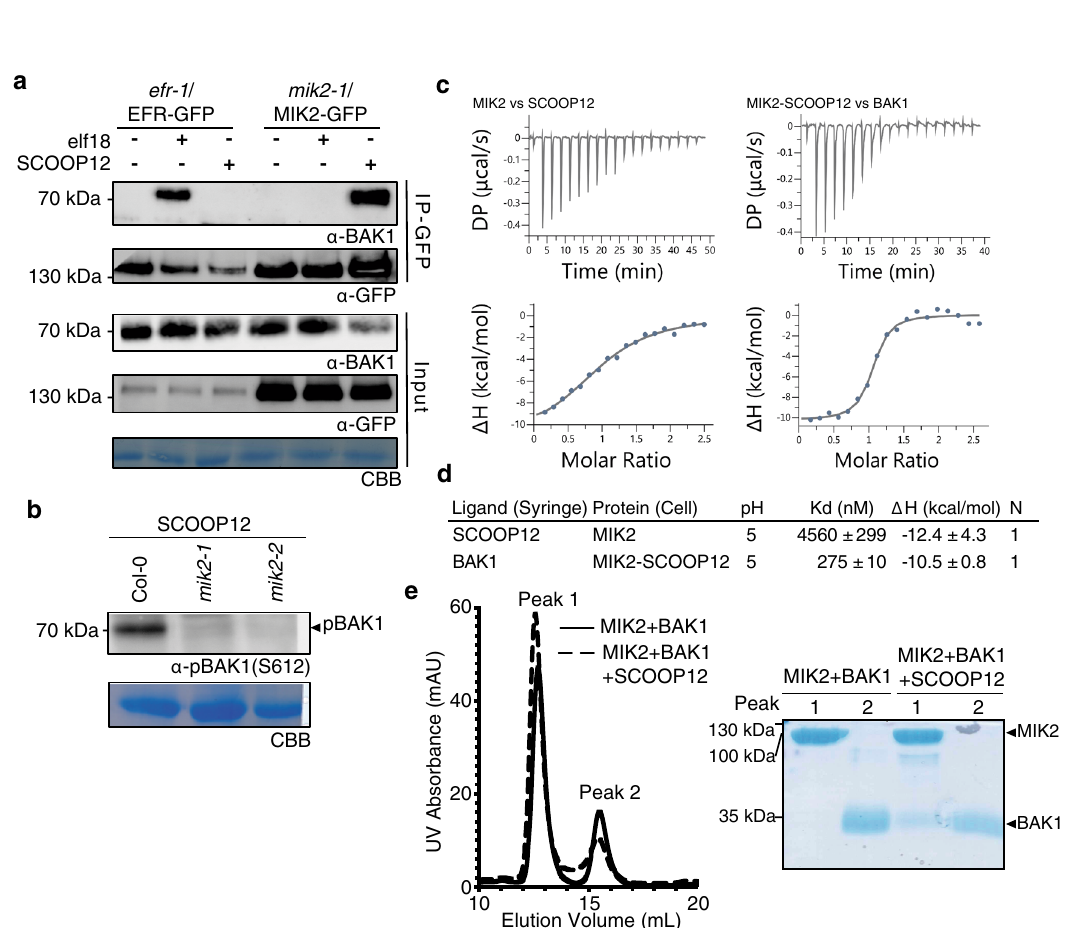
Fig. 2 SCOOP12 induces MIK2 – BAK1 complex formation. a Co-immunoprecipitation of BAK1 with MIK2 – GFP from mik2-1 /MIK2-GFP and EFR-GFP from efr-1 /EFR-GFP seedlings treated with 1 μ M elf18, 1 μ M SCOOP12, or water for 10 min. Western blots were probed with antibodies α -GFP and α -BAK1. b Western blot using α -pBAK1(Ser612) of seedlings after 15 min treatment with 100 nM SCOOP12. a , b were repeated three times with similar results. c ITC experiments of MIK2 vs SCOOP12, and MIK2 – SCOOP12 complex vs BAK1. Representative raw thermogram plots of ITC experiments. d ITC table summarizes of MIK2 vs SCOOP12, and MIK2 – SCOOP12 vs BAK1. The binding af fi nities between MIK2 and SCOOP12, and MIK2 – SCOOP12 and BAK1, are reported as K d , (dissociation constant, in nanomoles). The N indicates the reaction stoichiometry ( N = 1 for a 1:1 interaction). Δ H indicates the enthalpy variation. Values indicated in the table are means ± SD of independent experiments ( n = 3). Corresponding ITC runs are reported in Supplementary Figure 6. e Analytical SEC (left panel) of MIK2 – BAK1 complex in the presence and absence of SCOOP12. An SDS-PAGE of the peak fractions is shown alongside (right panel). ITC isothermal titration calorimetry, SEC size-exclusion